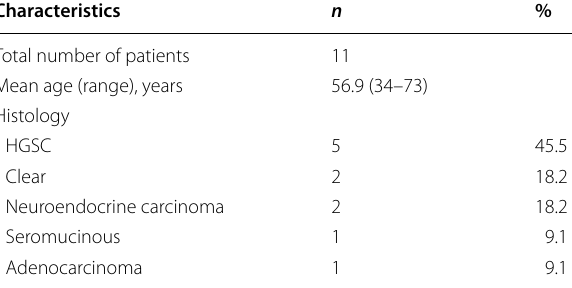
Table 4 Characteristics of patients with